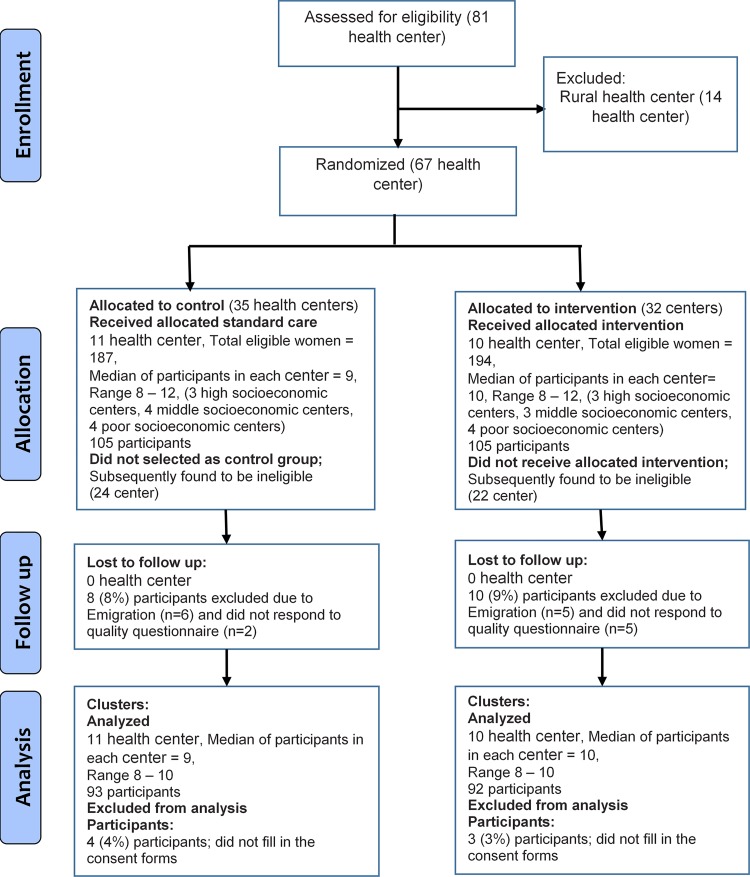
Eligibility and random allocation of study participants.